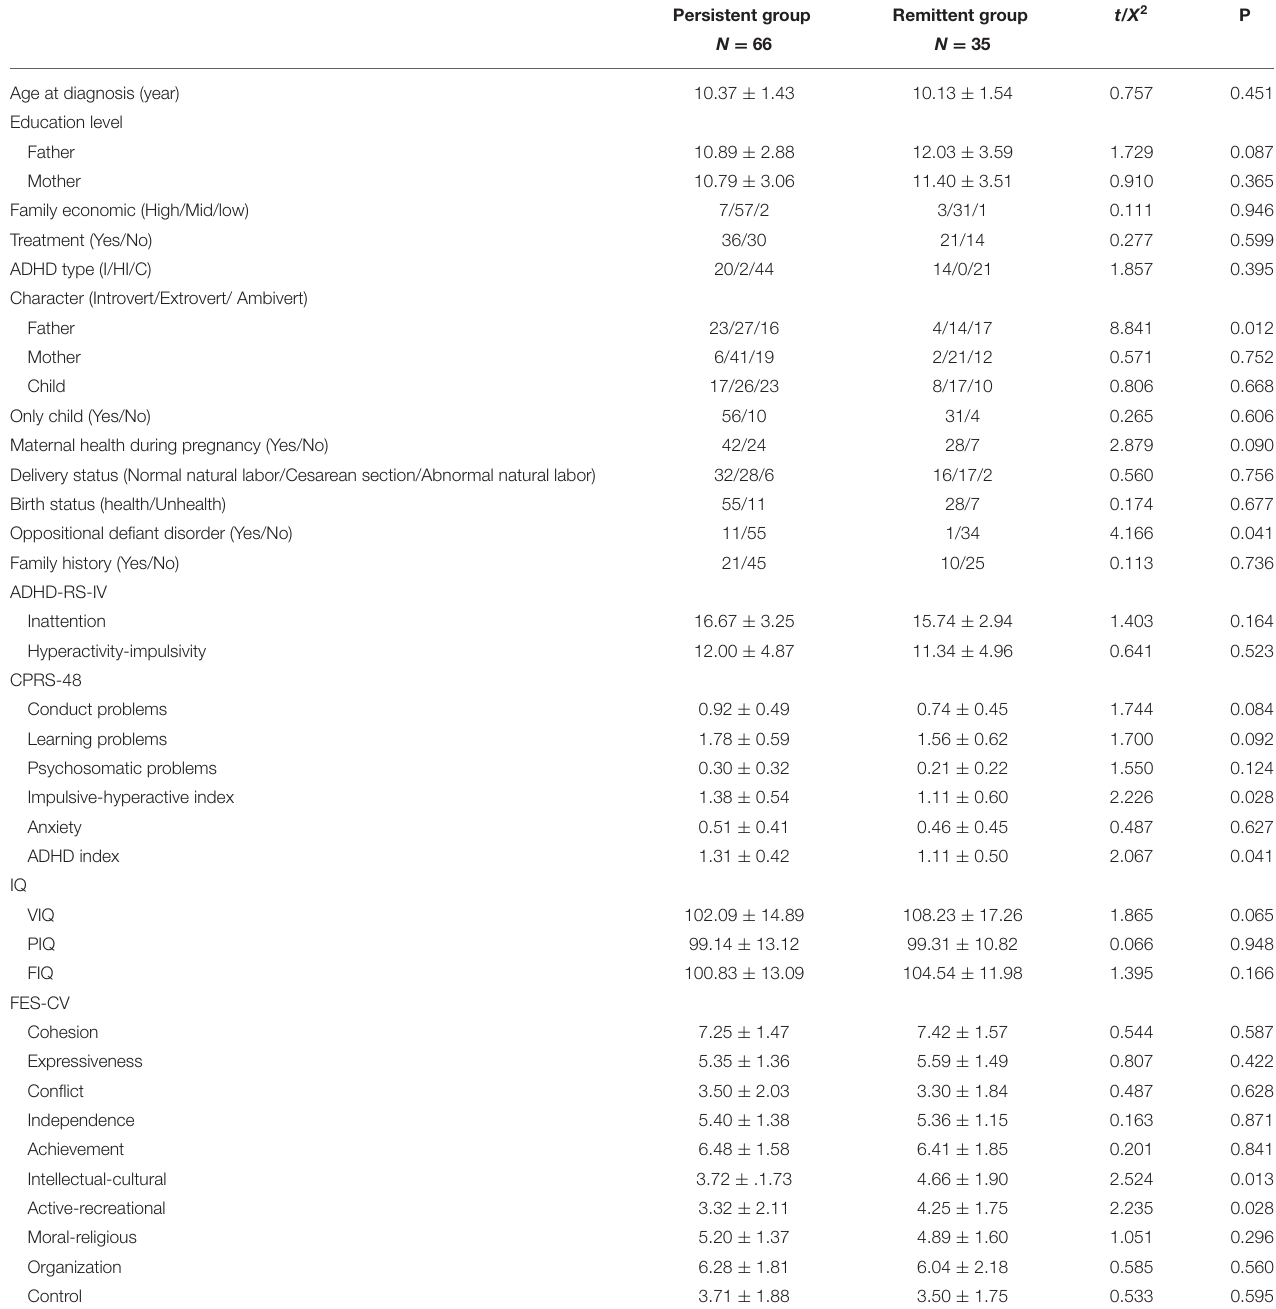
TABLE 1 | Comparisons of baseline characteristics between symptomatic persistence group and symptomatic relief